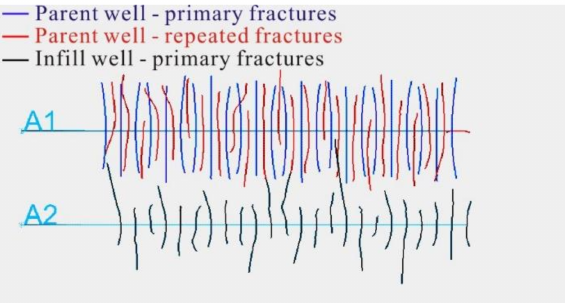
Figure 5. Fractures morphology of parent well and infill well after 1-year production (no water